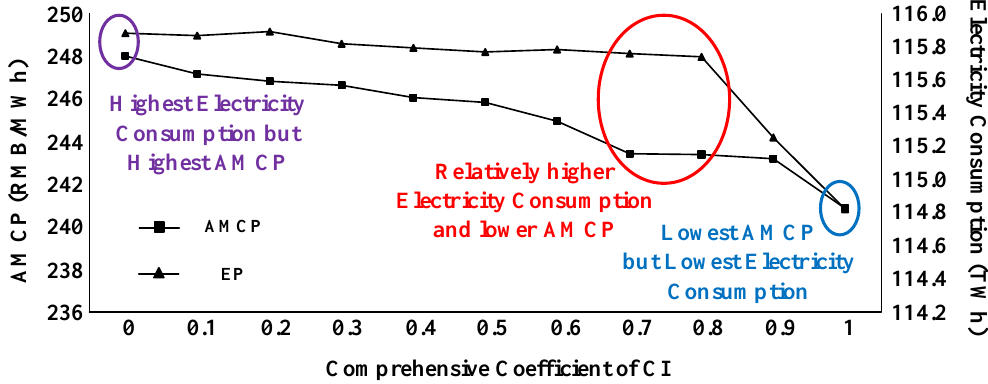
Figure 7. Impacts of the Comprehensive Indicator of Market Operation Situation (CI) coefficient on the average market clearing price and electricity